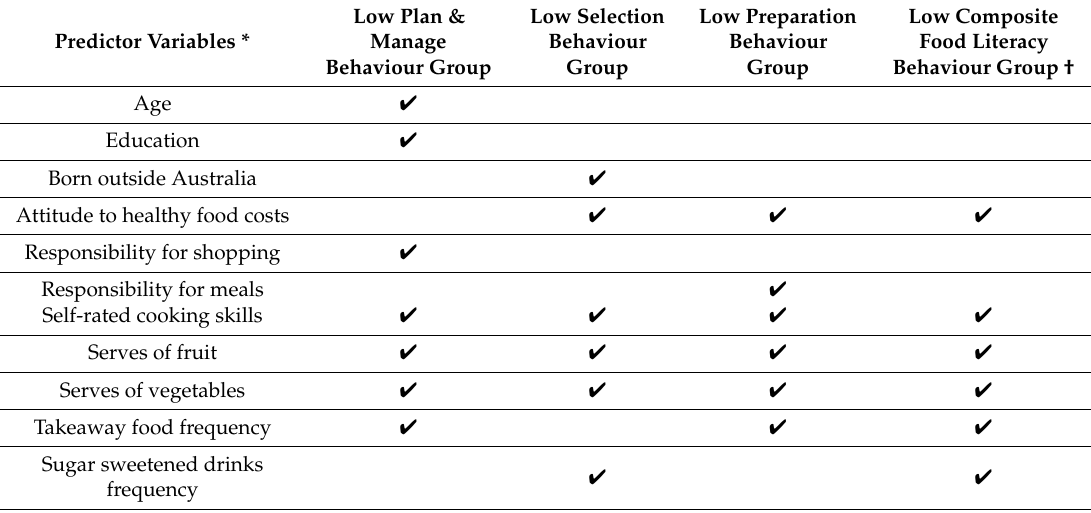
Table 3. Summary of variables predicting low food literacy